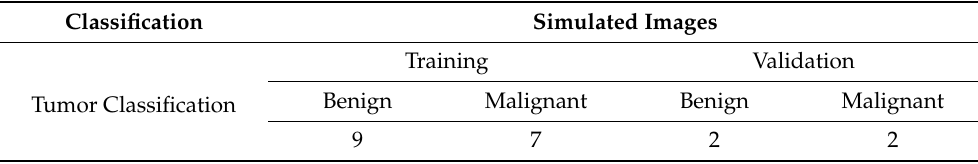
Table 1. Simulated images for the experiment.